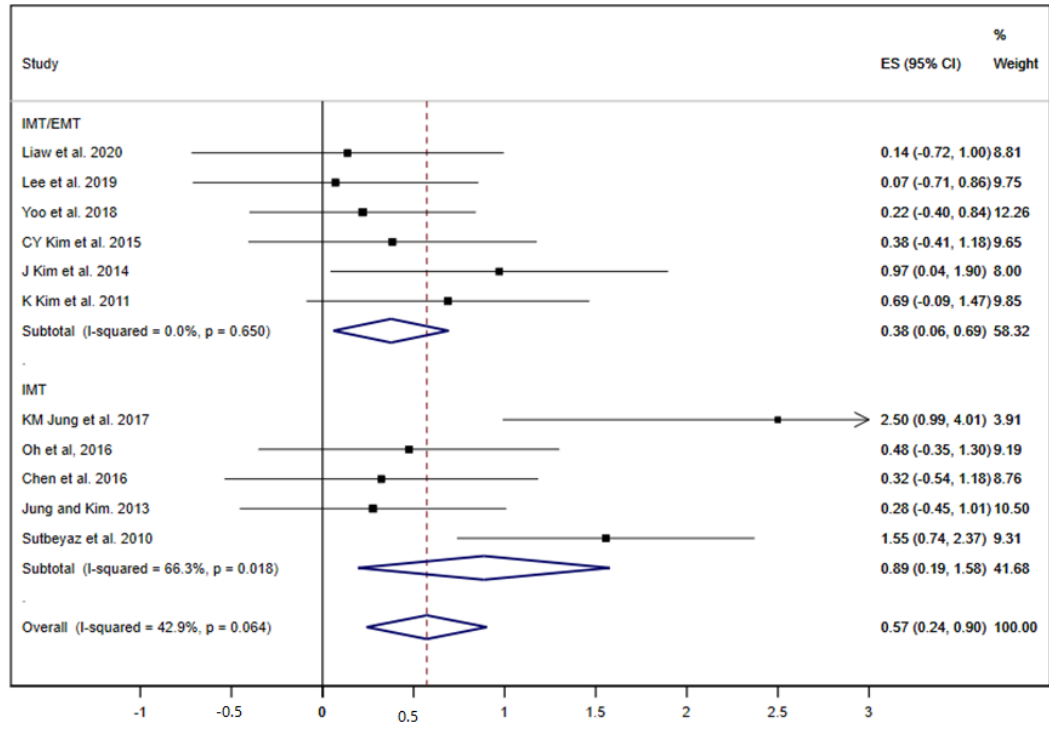
Figure 2. Forest plot showing the e ff ect size (ES) of respiratory muscle training (RMT) on first second forced expiratory volume (FEV1) between intervention and control groups for each study. IMT, inspiratory muscle training; EMT, expiratory muscle